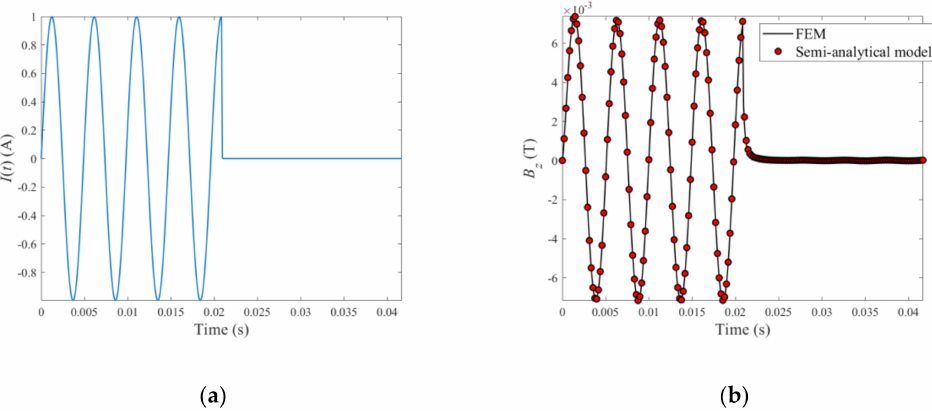
Figure 3. Excitation current and PMEC signals: ( a ) excitation current driving the probe; ( b ) signals predicted by the semi-analytical model and FEM.